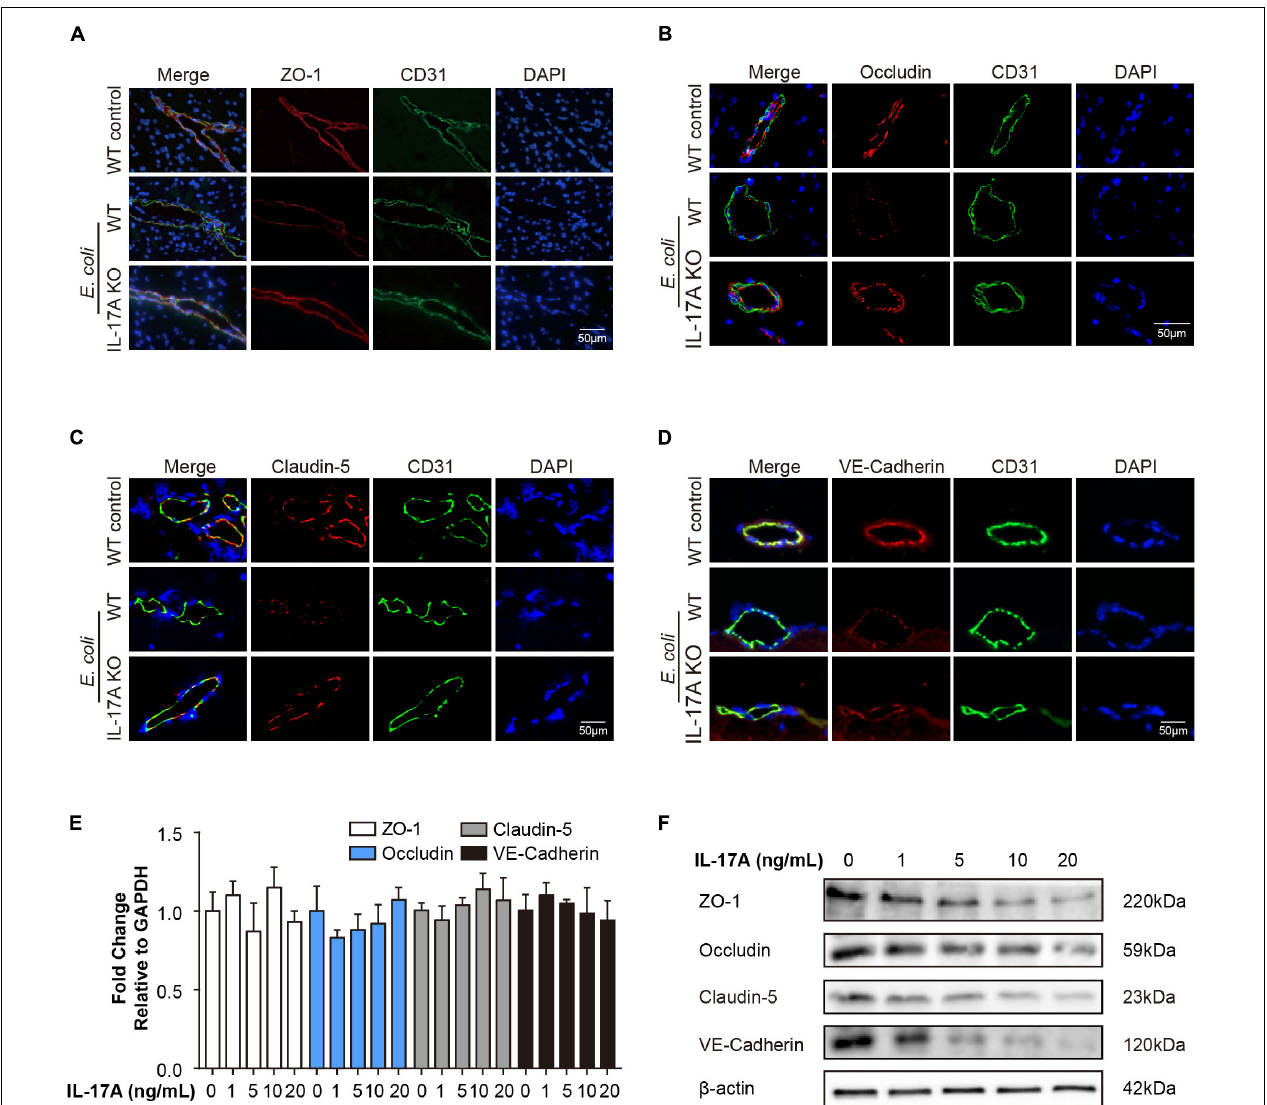
FIGURE 3 | Interleukin-17A treatment downregulates the expression of TJs and AJs. IF analysis of vascular endothelium integrity in infected WT or IL-17A KO mice. ZO-1 (A) , Occludin (B) , Claudin-5 (C) , and VE-Cadherin (D) were selected as the markers reflecting the integrity of the vascular endothelium. CD31 was applied explicitly for labeling the microvessels. Scale bar indicates 50 µ m. (E) The qPCR analysis of ZO-1, Occludin, Claudin-5, and VE-Cadherin transcription in hBMECs treated by multiple dosages of IL-17A (0, 1, 5, 10, and 20 ng/mL). GAPDH was used as the internal reference. Data were presented as mean ± SD from three independent experiments. (F) Western blot analysis of ZO-1, Occludin, Claudin-5, and VE-Cadherin in hBMECs in response to multiple dosages of IL-17A. β -Actin was used as the loading